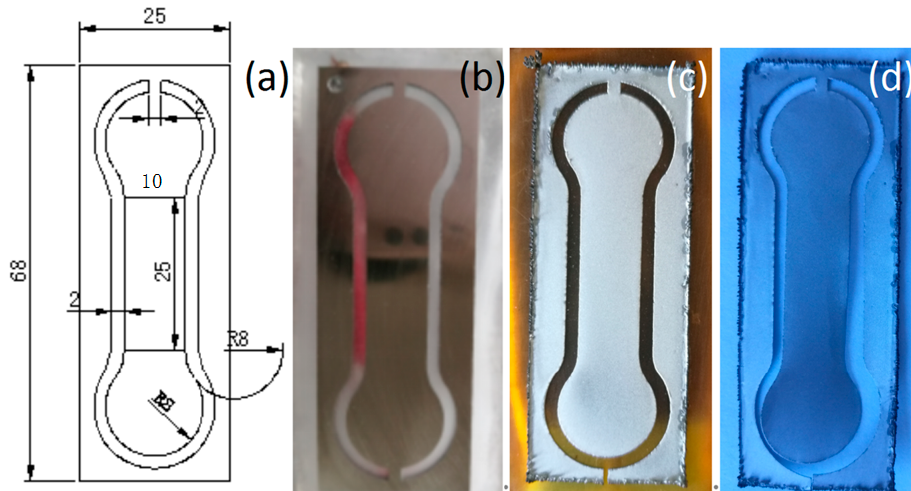
Figure 1. ( a ) The plan of the Ti template, ( b ) the Ti template after sealing using transparent epoxy and polishing using silicon carbide waterproof abrasive paper of 1000 Cw, ( c ) the Fe–Ni alloy foil electrodeposited on the Ti template, and ( d ) the stripped Fe–Ni alloy foil.